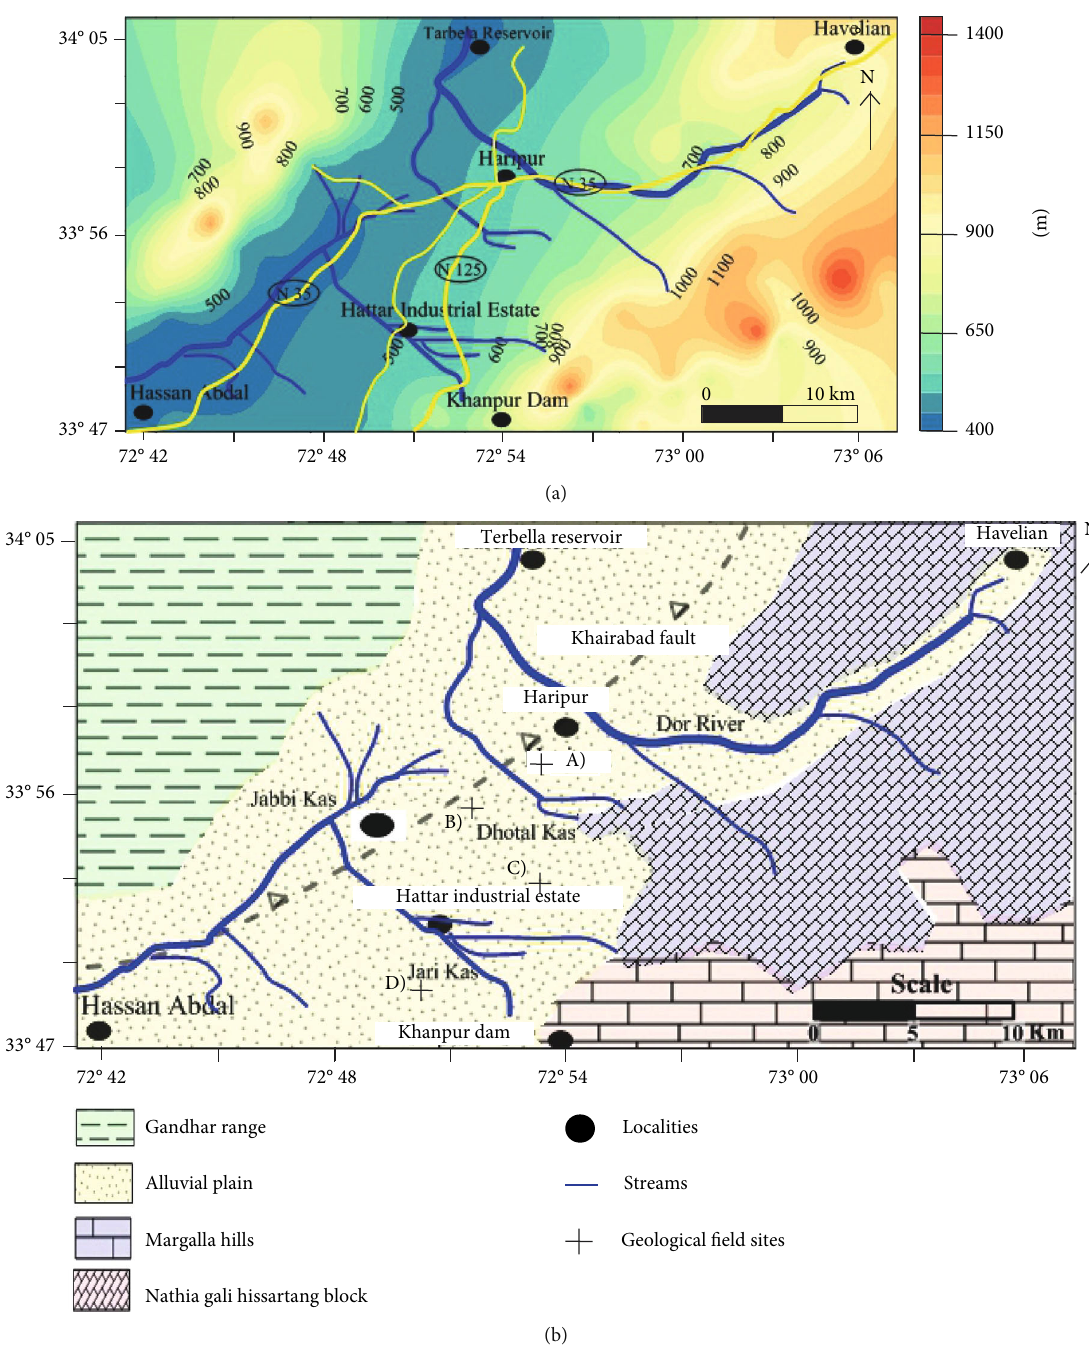
Figure 1: (a) Elevation map; (b) geological units in the study area (modi fi ed after [5]). The Haripur basin mainly comprises alluvium bounded by mountains. Tarbella reservoir lies in northwest, whereas dominant streams include Dhotal Kas and Jabbi